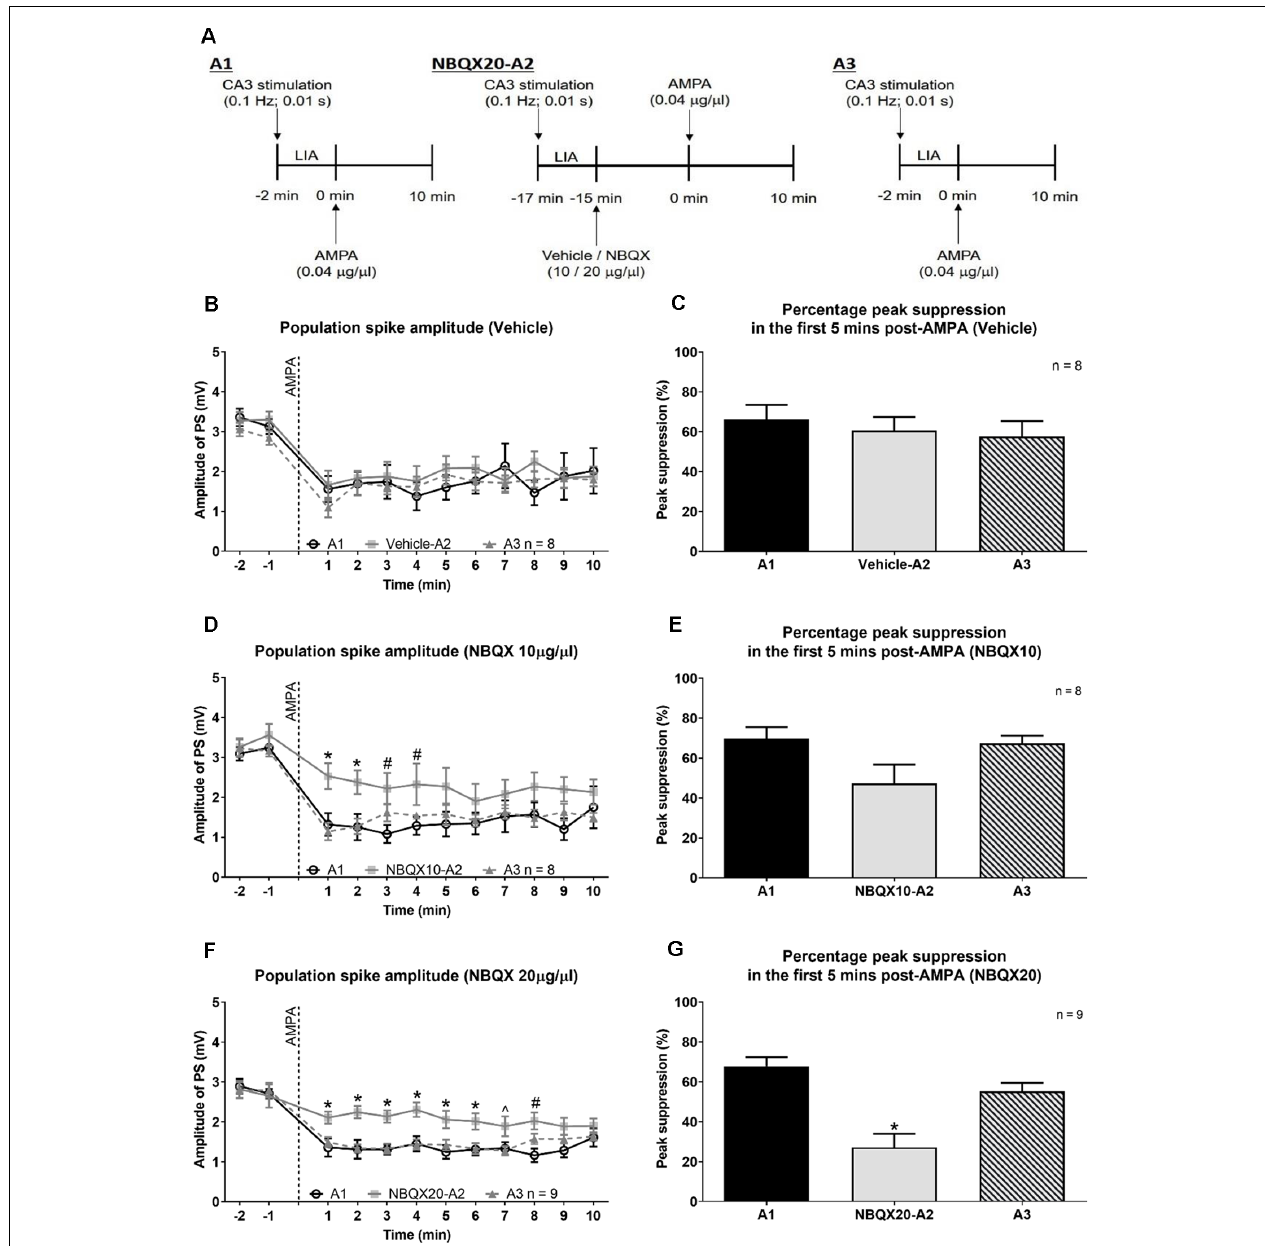
FIGURE 3 | The highest dose of NBQX, AMPA receptor antagonist, antagonizes AMPA-induced suppression of CA1 population spike. (A) Experimental timeline to investigate the effect of NBQX (20 µ g/ µ l, 0.5 µ l) on AMPA (0.04 µ g/ µ l, 0.5 µ l)-induced suppression of dorsal hippocampus field CA1 population spike (PS). The CA1 PS was evoked with CA3 stimulation (0.1 Hz, 0.01 s pulse duration). The intensity of stimulation was adjusted to evoke control PS that was 25% maximal under large irregular field activity (LIA). AMPA was microinjected thrice, 1 h apart, into the MS (labeled A1, A2, and A3). The time of each AMPA microinjection was taken as 0 min. The effect of AMPA microinjection was continuously monitored for 10 min. A prefix, “NBQX20”, was added to A2 to indicate that NBQX was microinjected 15 min before the second AMPA microinjection ( − 15 min in A ). The effect of microinjections on CA1 PS was analyzed in 1 min block. The time course of change is illustrated in (B,D , and F) wherein AMPA microinjection is indicated by the vertical line at time 0 min. The corresponding histograms (C,E, and G) show the percentage peak suppression induced in the first 5 min following AMPA microinjection. The percentage peak suppression was calculated from the average of the smallest PS amplitudes in two contiguous minutes within the first 5 min of AMPA microinjection expressed as a percentage of control PS amplitude. The control PS amplitude was the average amplitude in the 2 min before AMPA microinjection. Note that NBQX20 pre-treatment attenuated the suppression of CA1 PS induced by AMPA (F,G) . The effect of NBQX20 was persistent. In contrast, NBQX10 resulted in a brief block of AMPA-induced PS amplitude (D) with no significant decrease in percentage peak suppression (E) . Data are mean ± S.E.M. Significant difference ( p < 0.05): (D,F) Time course: *NBQX20-A2 or NBQX10-A2 vs. A1 and A3, # NBQX20-A2 or NBQ10-A2 vs. A1, ∧ NBQX20-A2 vs. A3; two-way RM ANOVA followed by Bonferroni post hoc test. (G) Histograms: *vs. A1 and A3, one-way RM ANOVA followed by Newman-Keuls post hoc